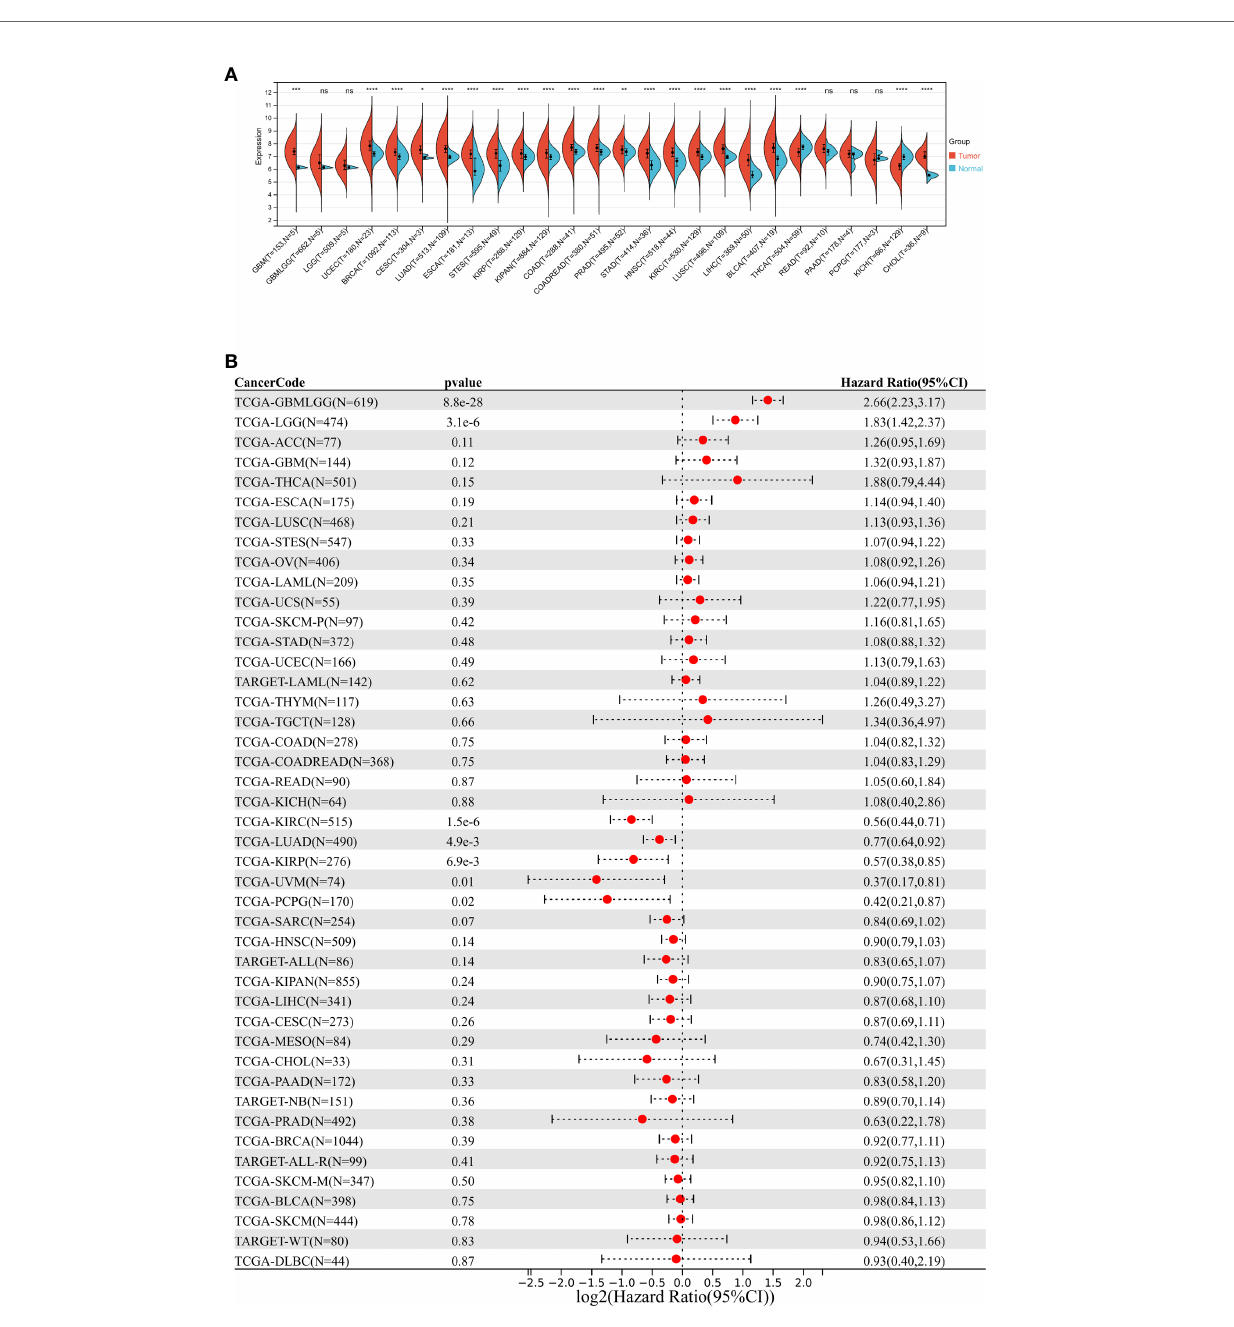
FIGURE 1 | Pan cancer analysis of DDOST expression. (A) Analysis of DDOST expression in 33 tumors on TCGA. *, **, ***, **** indicate p < 0.05, p < 0.01, p < 0.001, and p < 0.0001, respectively; ns, not signi fi cant (Wilcoxon test). (B) Risk plot of correlation between DDOST levels and